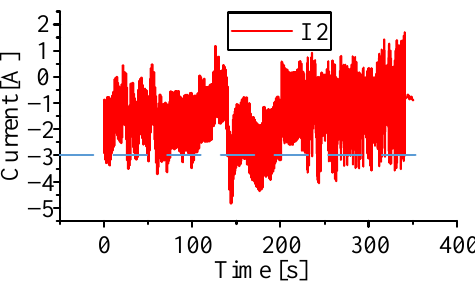
Figure 12. The adjacent cell balancing circuit.